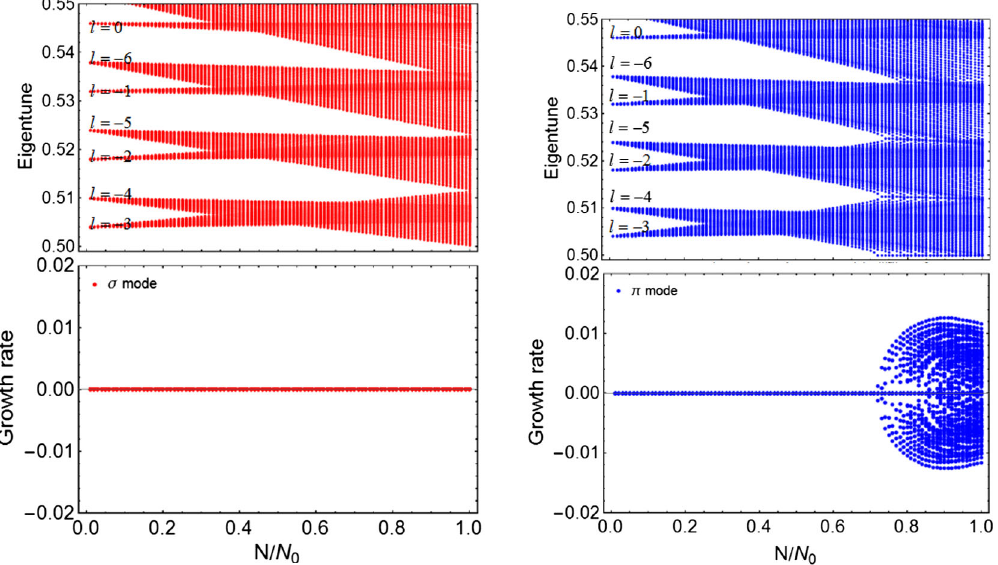
¼ 0 . 546 . In this case, we assume x